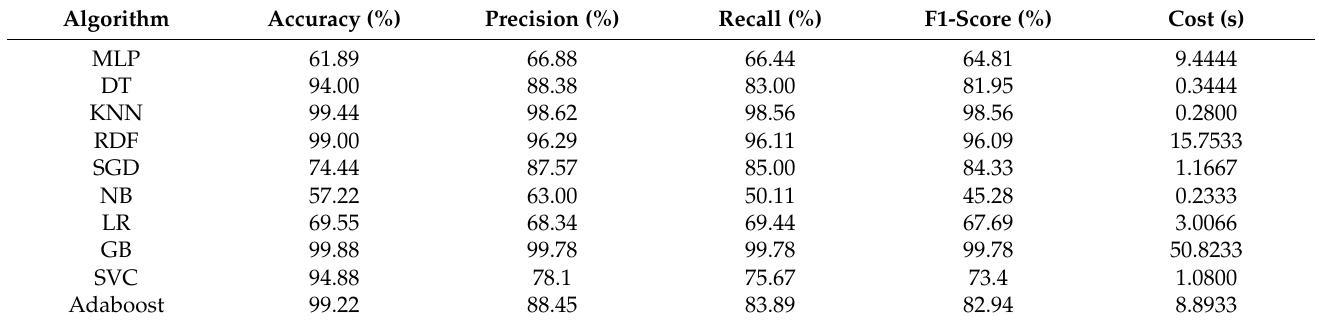
Table 10. Global performance comparison of ML models using combination of (Z) and (D) features.